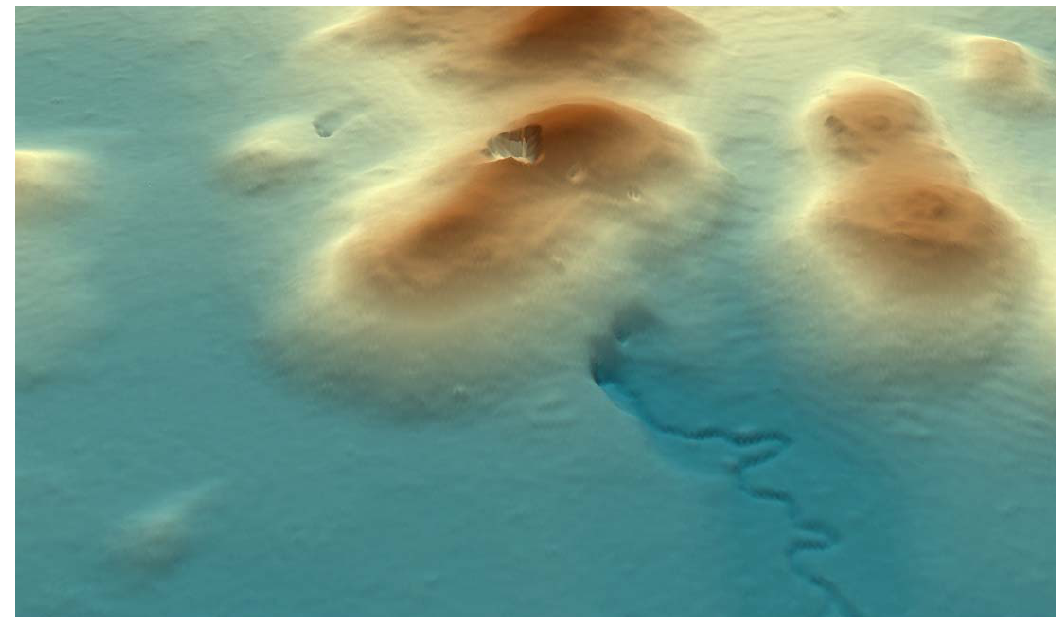
Figure 13. Lidar image showing drainage inflow indicating the presence of a cave entrance (Actun P’ook or Sombrero Cave). P’ook or Sombrero